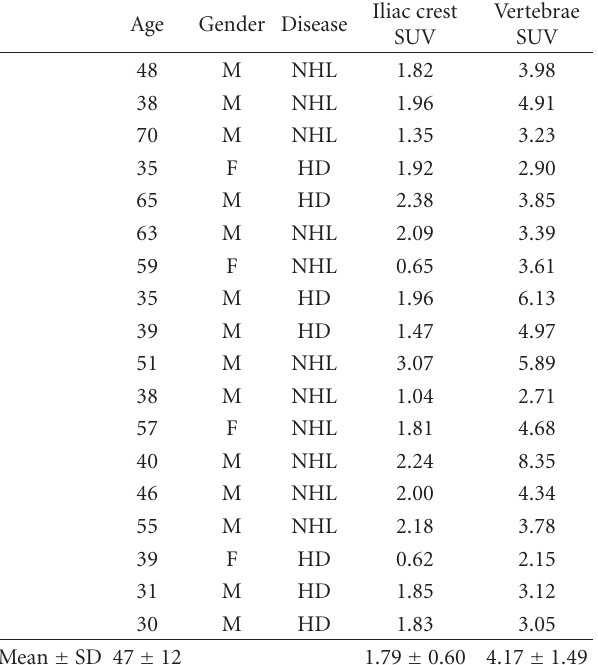
Table 2: Main clinical characteristics and SUV values of control subjects. Iliac crest Gender Disease